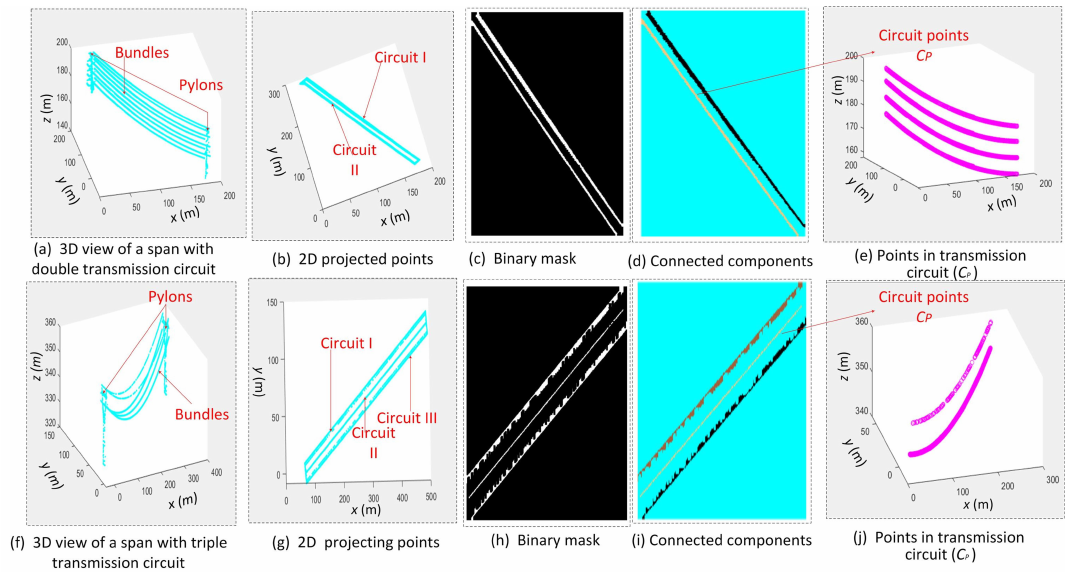
Figure 3. Extraction of the set of points in each transmission circuit of a double-circuit span ( a – e ) and a triple-circuit span ( f – j ). In panels ( a – e ) the origin (0, 0) represents (5.1435 × 10 5 , 6.9225 × 10 6 ) and in panels ( f – j ) the origin (0, 0) represents (4.08000 × 10 6 , 5.90355 × 10 5 ). The points in C p are divided into several segments, each 12 m long along the span